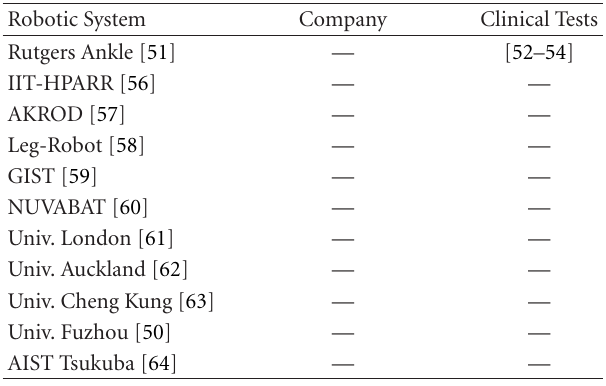
Table 4: Stationary robotic gait trainers.